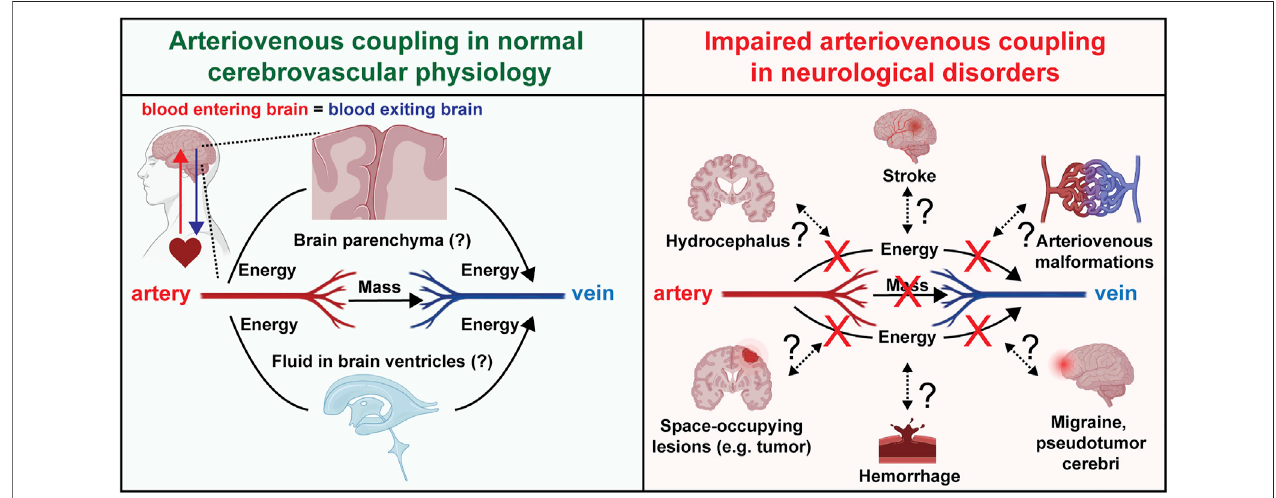
FIGURE 3 | Arteriovenous coupling in normal physiology and neurological disorders. Schematic depicting hypotheses regarding arteriovenous coupling in normal cerebrovascular physiology and potential involvement in multiple human neurological